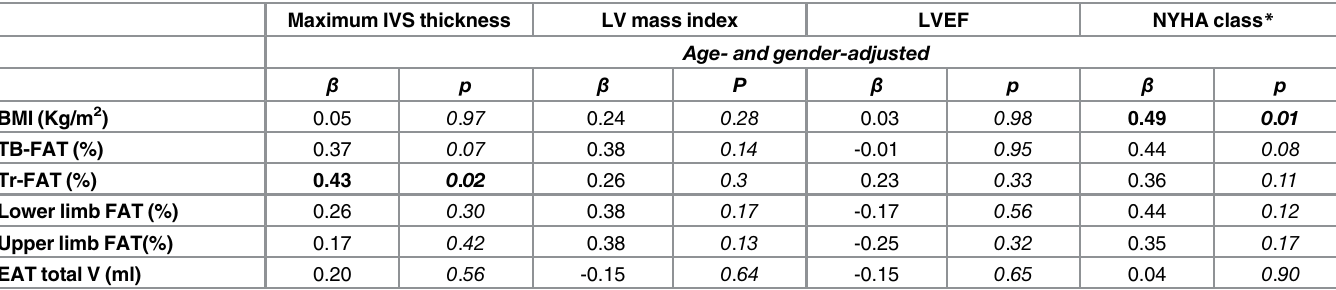
Table 2. Age- and gender-adjusted associations between hypertrophy extent, NYHA class and adiposity distribution